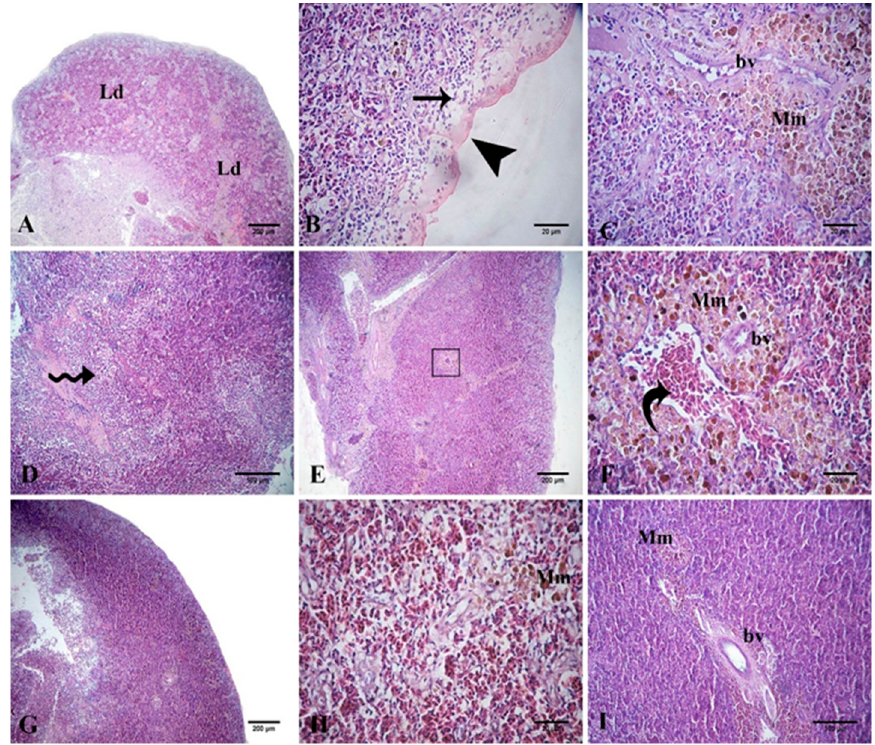
Figure 7. Representative photomicrographs of the H&E-stained Nile tilapia spleen-tissue sections following the A. sobria challenge. The A. sobria -challenged control fish ( A – C ) showing lymphoid depletion (Ld), necrosis (arrow) under the capsule (arrowhead), and activation of the melanomacrophage centers (Mm) around the blood vessel (bv). Challenged QU 10 -supplemented fish ( D ) showing diffuse infiltration of the inflammatory cells (zigzag arrows). Challenged QU 20 -supplemented fish ( E ) and its image at high magnification ( F ), showing the activation of the melanomacrophage centers (Mm) around the blood vessel (bv) and hemorrhage, with aggregates of the RBCs (curved arrow). Challenged PP 10 -supplemented fish ( G , H ) showing mild necrosis ( G ) and a mild increase in the melanomacrophage cells (Mm) ( H ). Challenged PP 20 -supplemented fish ( I ) showing a mild increase in the melanomacrophage cells (Mm) around the splenic blood vessels (bv).